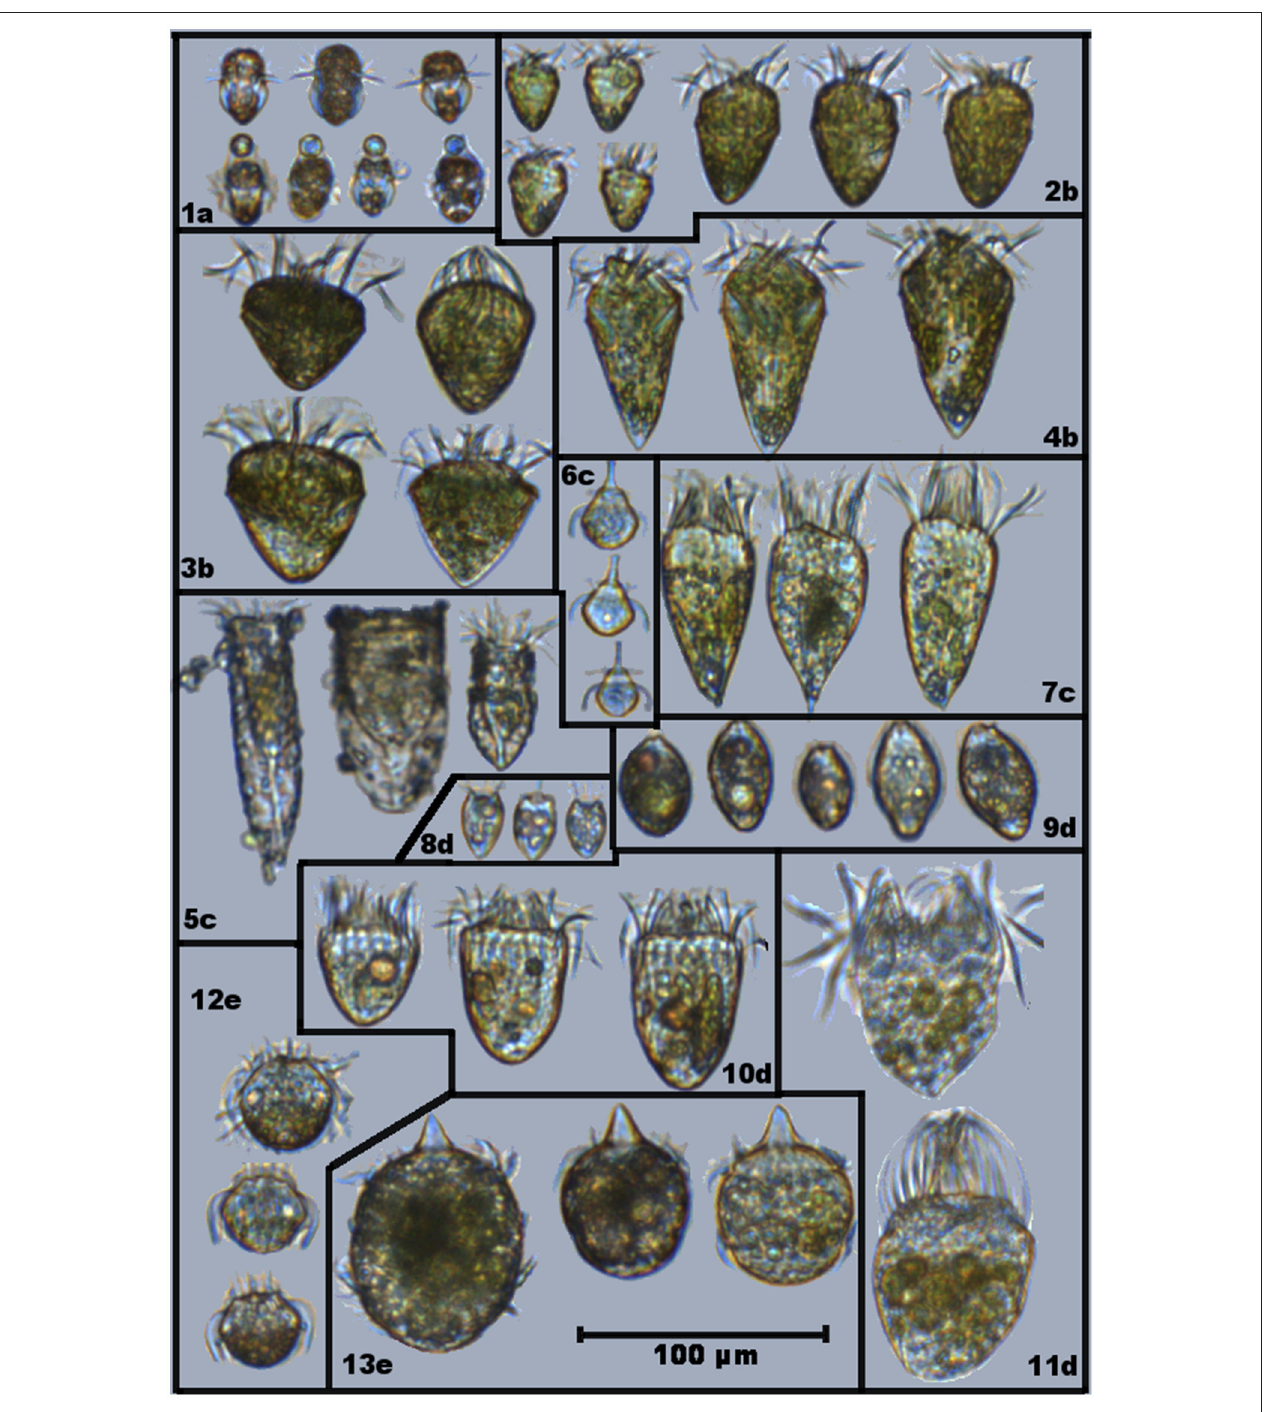
FIGURE 1 | Selected images showing different ciliates morphotypes found in Roskilde Fjord during the study period: (1) Mesodinium rubrum ; (2) Strombidium spp; (3) Strombidium cf. capitatum ; (4) Strombidium cf. conicum ; (5) Tinitinnids; (6) Mesodinium cf. velox ; (7) cf. Pelagostrobilidium ; (8) Balanion comatum ; (9) cf. Urotricha ; (10) Choreotrichida; (11) Oligotrichida; (12) Askenasia ; and (13) Didinium . Assigned trophy strategies are displayed as letters, accompanying the morphotypes numbers: (a) Specialist Non-Constitutive Mixotroph (SNCM); (b) General Non-Constitutive Mixotroph (GNCM); (c) Selective phagotroph (SP); (d) Generic phagotroph (GP); and (e) Carnivore (Cv). Note that some of displayed cells of M. rubrum (1a) are grabbing particles that are not their preferential prey ( Teleaulax spp).